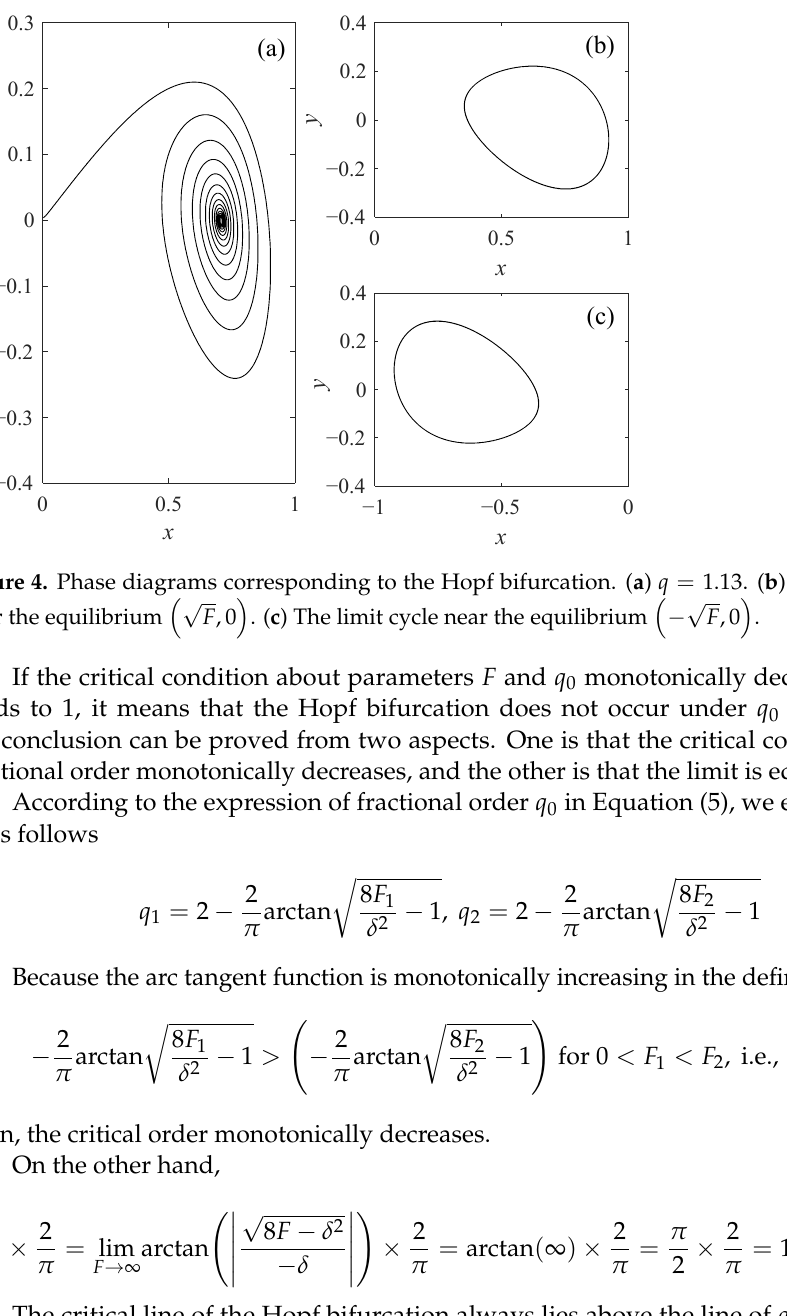
5 of 13 Figure 3. The bifurcation diagram about Equation (3) for equilibrium   ,0 F  . 2.2. Hopf Bifurcation Based on reference [25], the critical conditions of Equation (5) about point 